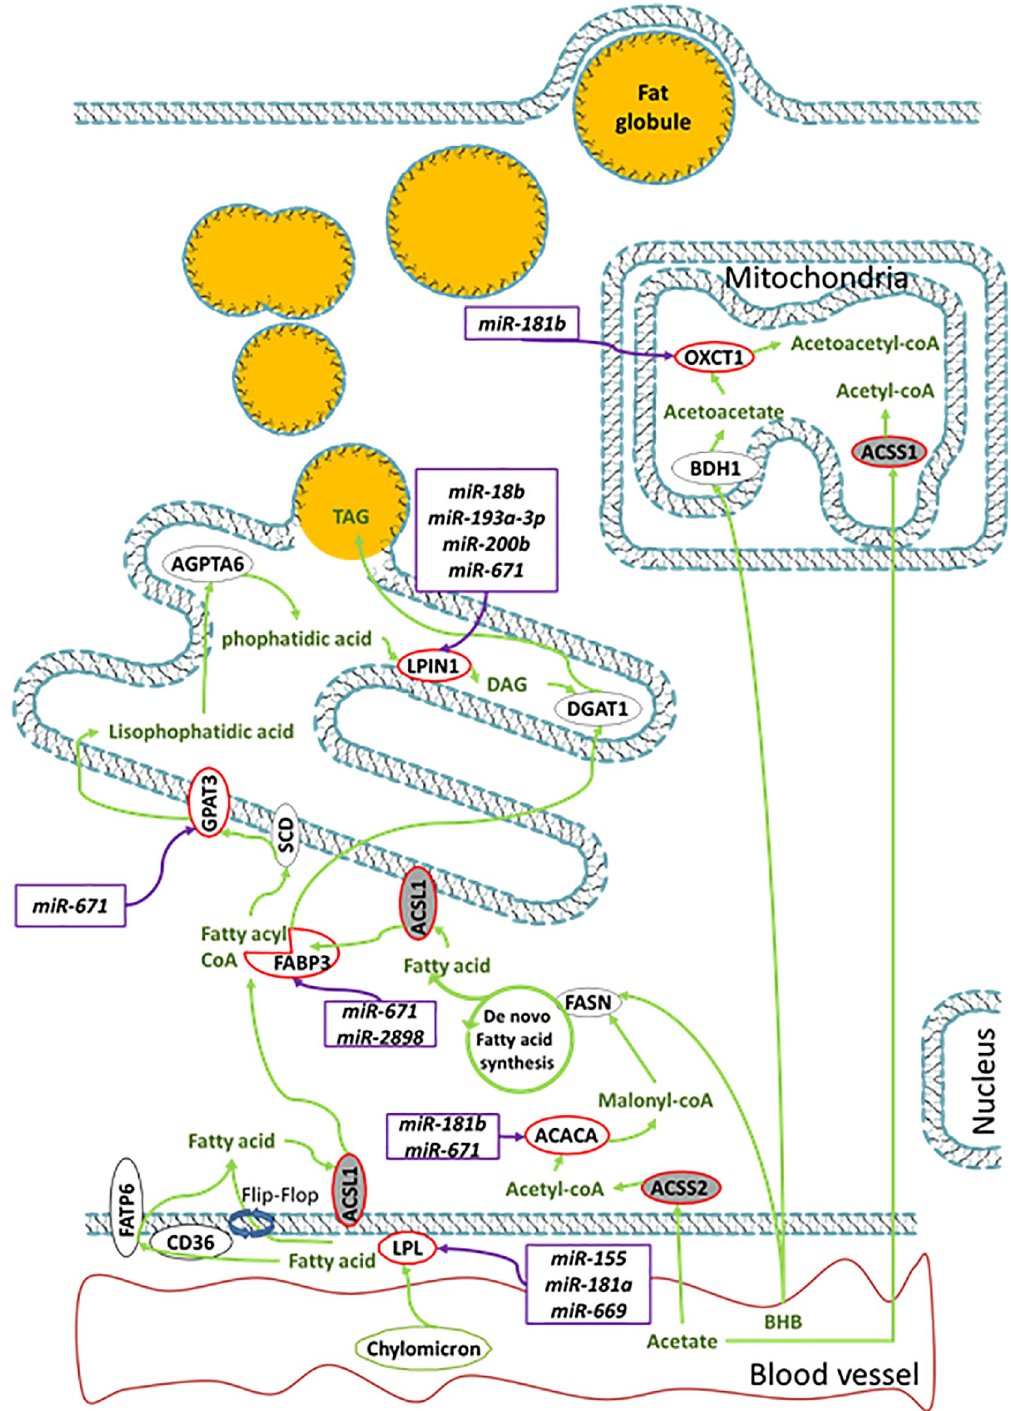
Fig 1. MiRNAs and coding genes involved in the milk fat synthesis pathway. Genes in the red circle correspond to DEGs identified in our study, and miRNAs in the purple box correspond to DEMs targeting the DEGs (adapted from Bionaz and Loor